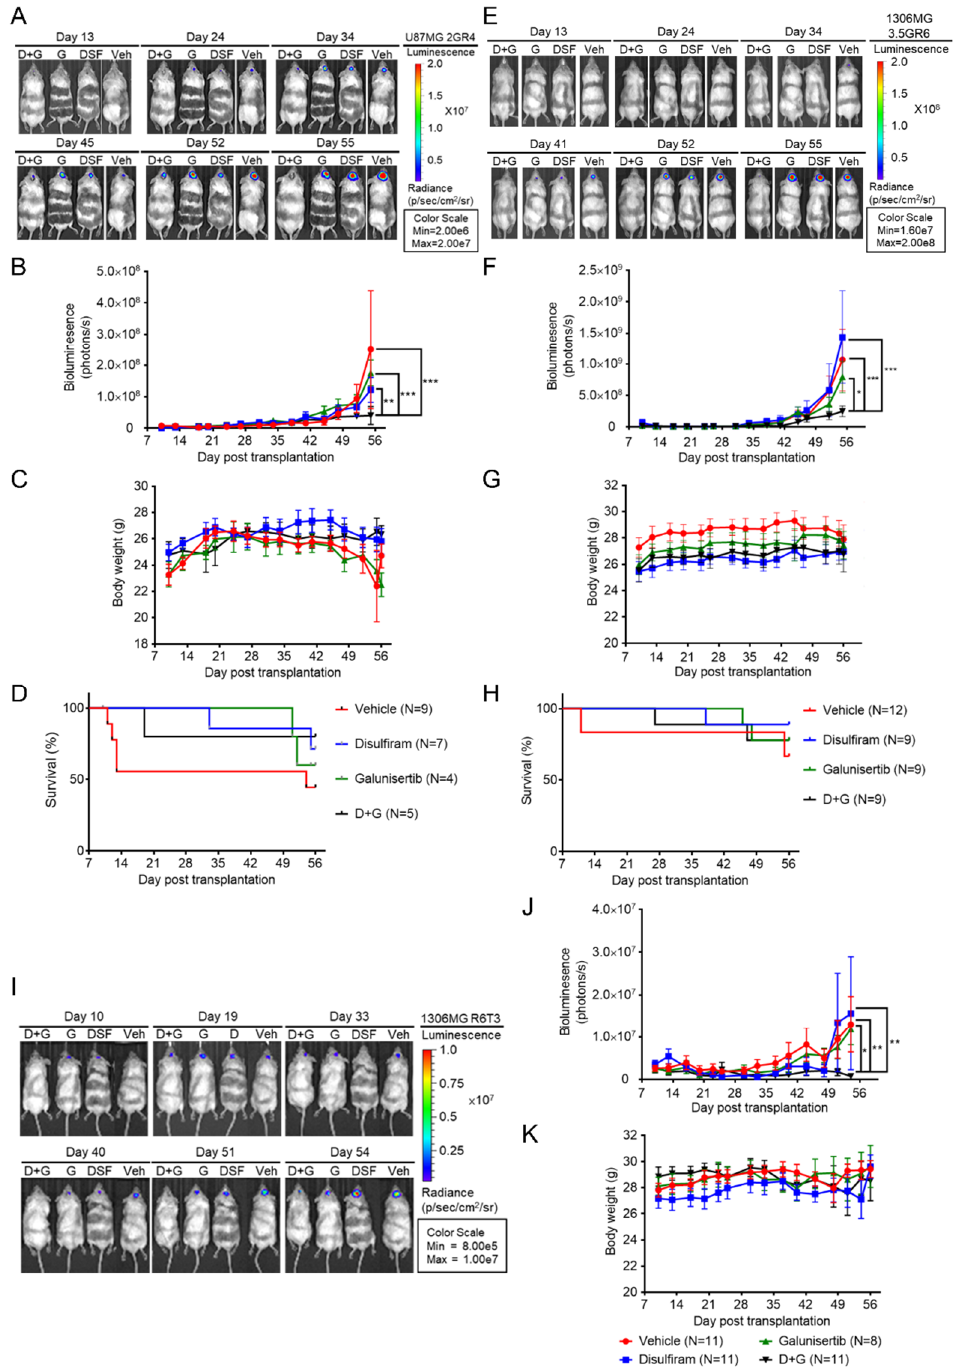
Figure 8. Combining DSF and Galunisertib shows better anti-tumor efficacy than sole treatments. The Luciferase (Luc)-expressing radiation-resistant U87MG 2GR4, or radiation-resistant 1306MG 3.5GR6, or radiation-TMZ-resistant 1306MG R6T3 cells (5 × 105 cells in 2 μL PBS) were injected into the striatum of the brain of NOD-SCID mice. At day 10 post-transplantation, DSF (50 mg/kg), Galunisertib (75 mg/kg), DSF (50 mg/kg) + Galunisertib (75 mg/kg), or DMSO as a vehicle was injected intraperitoneally twice weekly into the mice. Bioluminescence was used to monitor tumor growth with the IVIS-200 imaging system twice weekly and tumor growth was observed for 45 days. ( A ) Graphs showing the in vivo tumor growth of radiation-resistant U87MG 2GR4 cells; ( B ) histogram indicating the bioluminescent photons of tumor cells; ( C ) histogram showing the changes in body weight; ( D ) Kaplan–Meier survival curve of the vehicle-, DSF-, G-, and D + G-treated mice; ( E ) graphs showing the in vivo tumor growth of radiation-resistant 1306MG 3.5GR6 cells; ( F ) histogram indicating the bioluminescent photons of tumor cells; ( G ) histogram showing the changes in